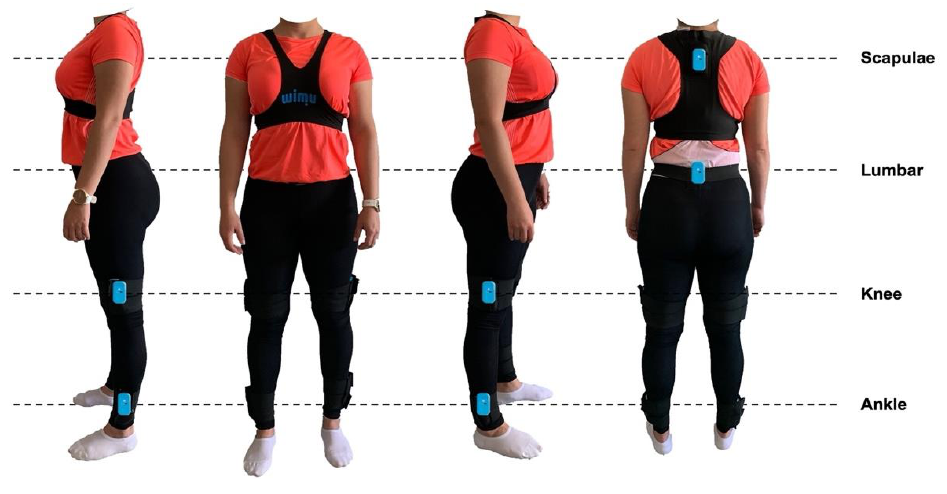
Figure 1. Placement of the inertial devices in women’s basketball players.